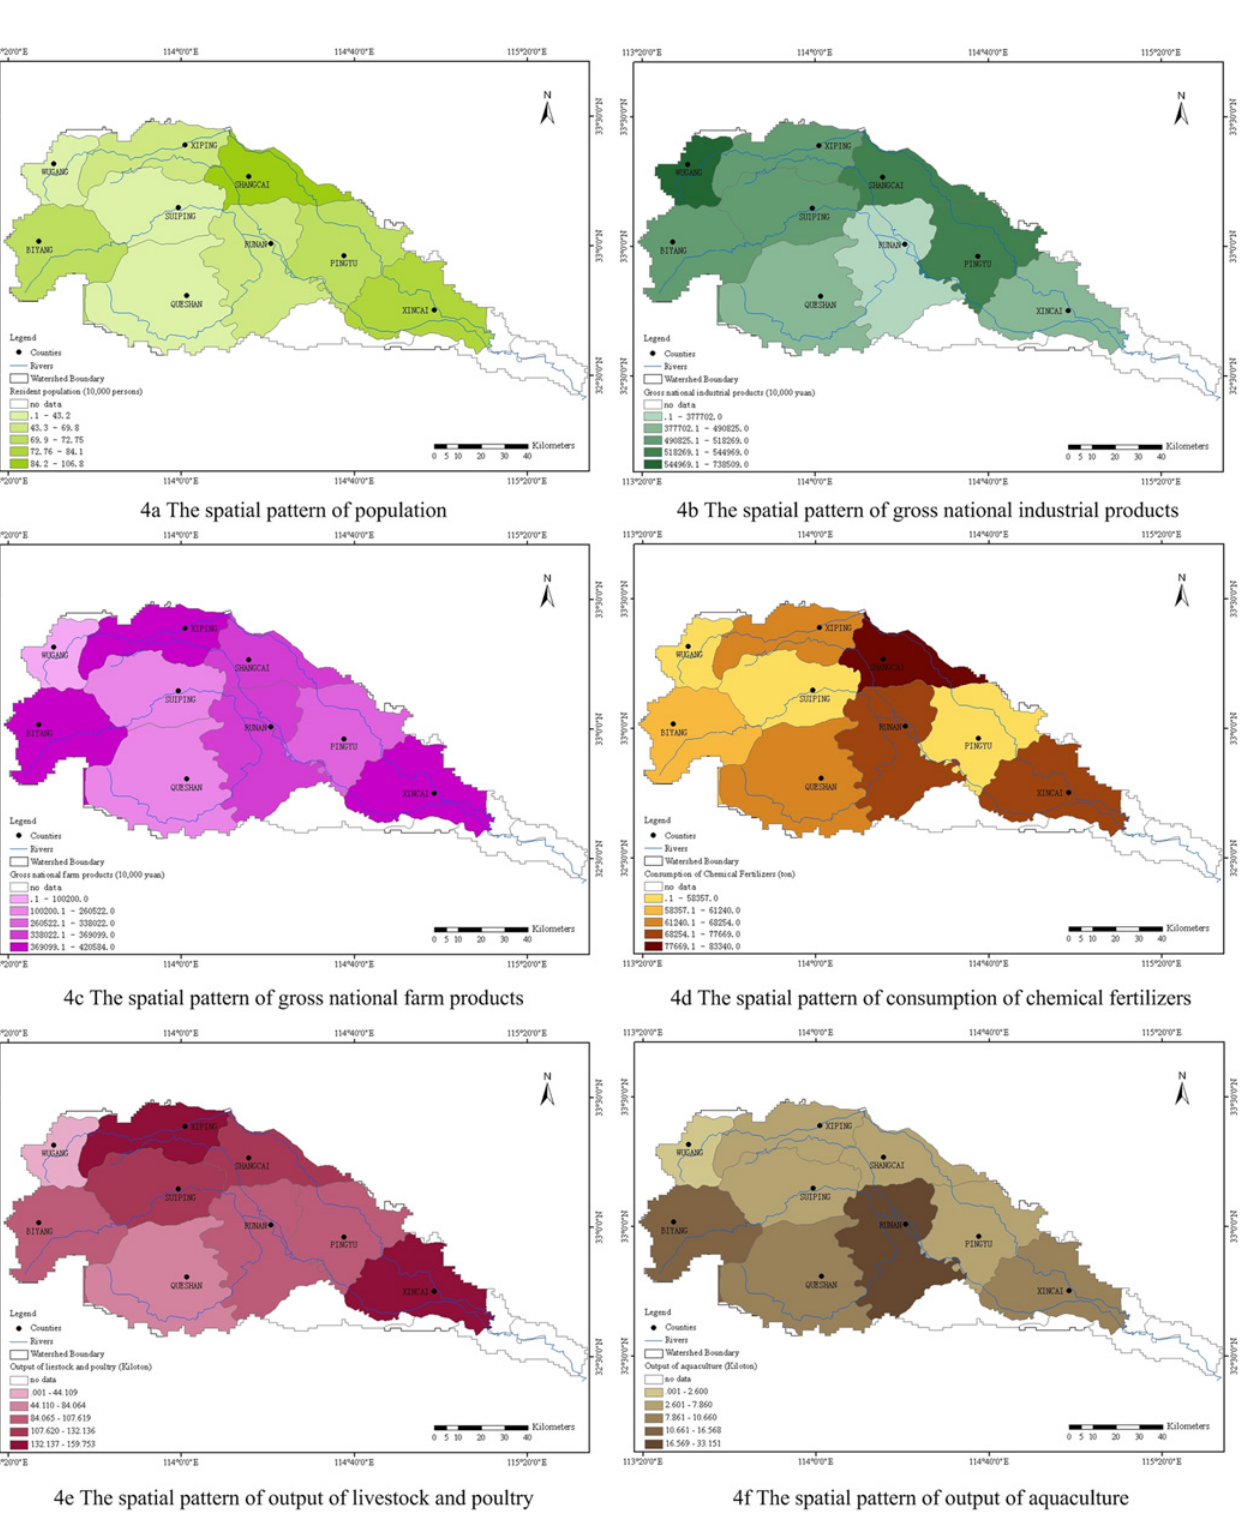
Fig 4. The spatial pattern of the major social-economic statistical indicators at county level of the Honghe River Watershed in 2011.